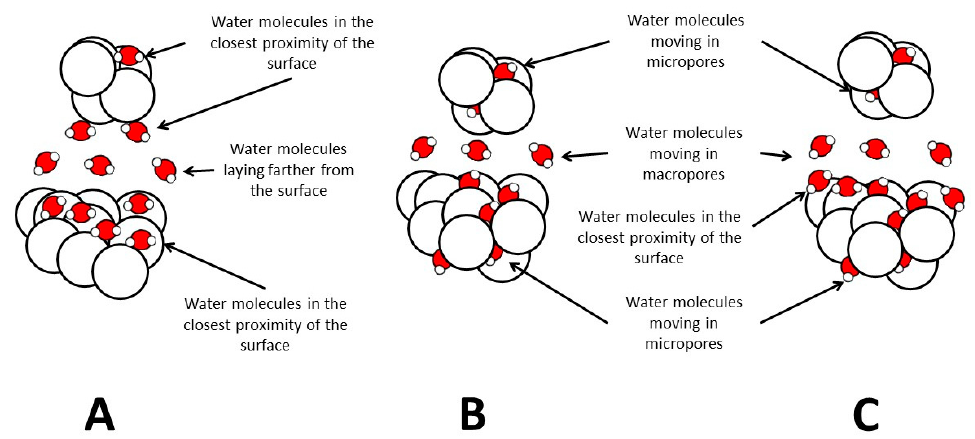
Figure 4. Different dynamics of water molecules in the quadrupolarless-nuclei quartz sand used as a porous system model (white circles). The biexponential assumption used to apply Equations (2) and (3) is valid only for A , and B . In case C , a three-exponential model should be applied.